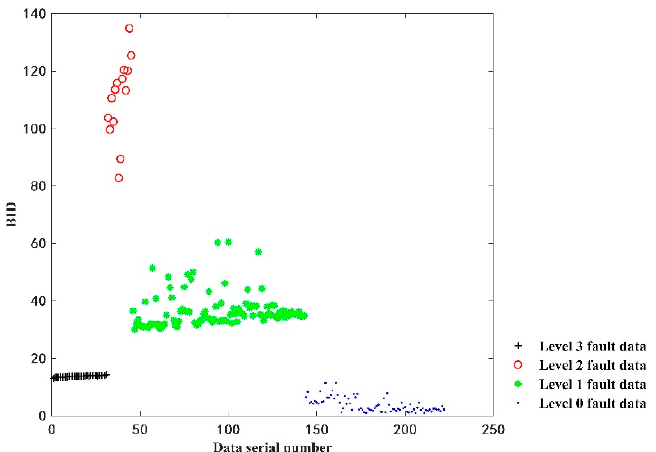
Figure 7. BID fusion results of the vehicle battery.